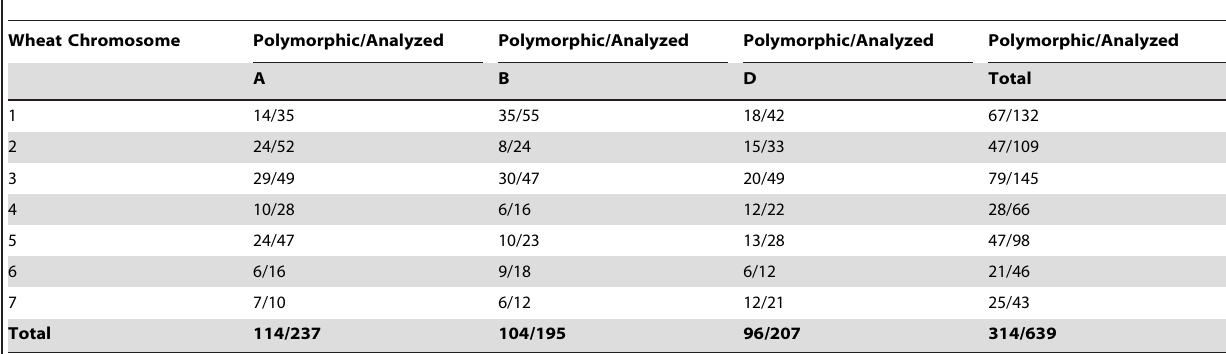
Table 1. Polymorphism survey of ‘Zak’ and the Yr15 gene donor line using SSR markers.